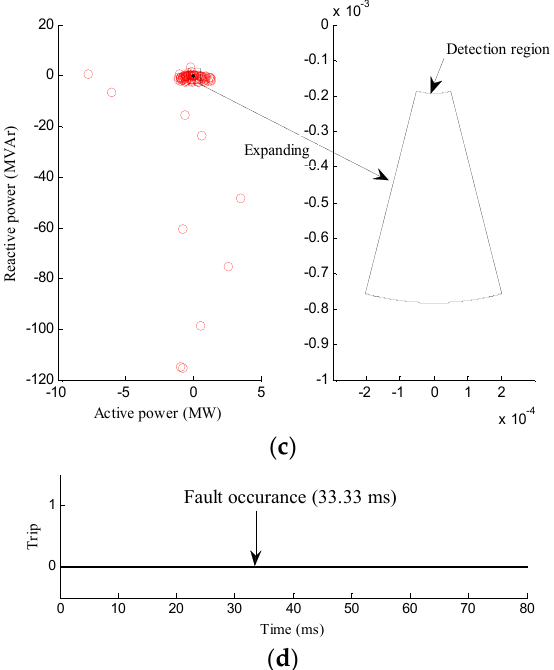
Figure 12. Results for Case 10. ( a ) v a , b , c (upper) and i a , b , c (lower); ( b ) p 3 ph (upper) and q 3 ph (lower); ( c ) Trajectories of the point ( p 3 ph , q 3 ph ); ( d ) Islanding detection signal.